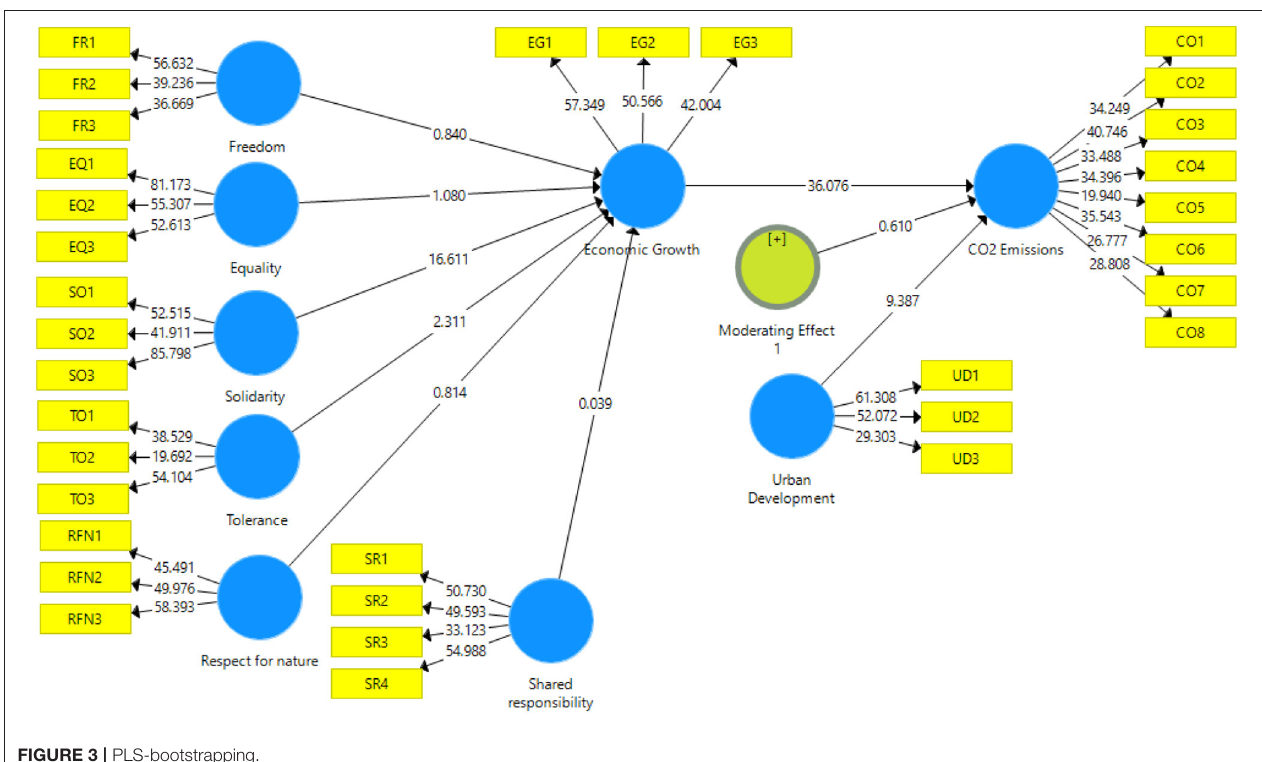
FIGURE 3 | PLS-bootstrapping.